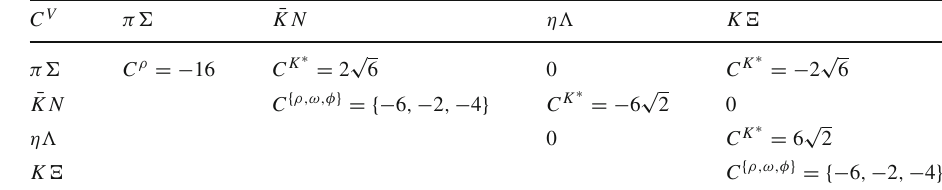
Table 2 Coefficients C B of the Born terms in M j B j , M i B i